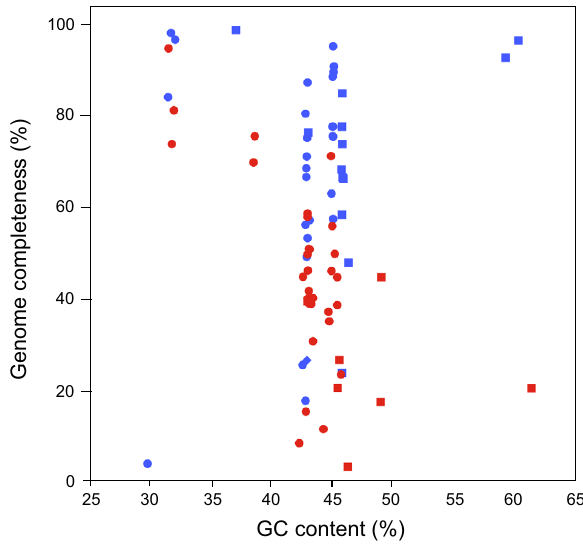
Figure 4. Relationships between genome completeness and GC contents of single-cell genomes in the mock community of human gut bacteria. Single-cell amplified genomes (SAGs) from the mock community comprising 15 strains of human gut bacteria are plotted with their GC contents against their genome completeness. The SAGs were assembled from 0.3 M randomly chosen read pairs, while MS485-1-51 of MDA- in-AGM (0.26 M read pairs) and CS1–94 of FACS-MDA (0.29 M read pairs) used all read pairs since they were fewer than 0.3 M. The bacterial species comprising the mock community and detailed results are shown in Supplementary Tables S4–S6. Blue and red indicate MDA-in-AGM and FACS-MDA, respectively. Squares, circles and rhombuses indicate gram-positive, gram-negative and gram-variable bacteria,